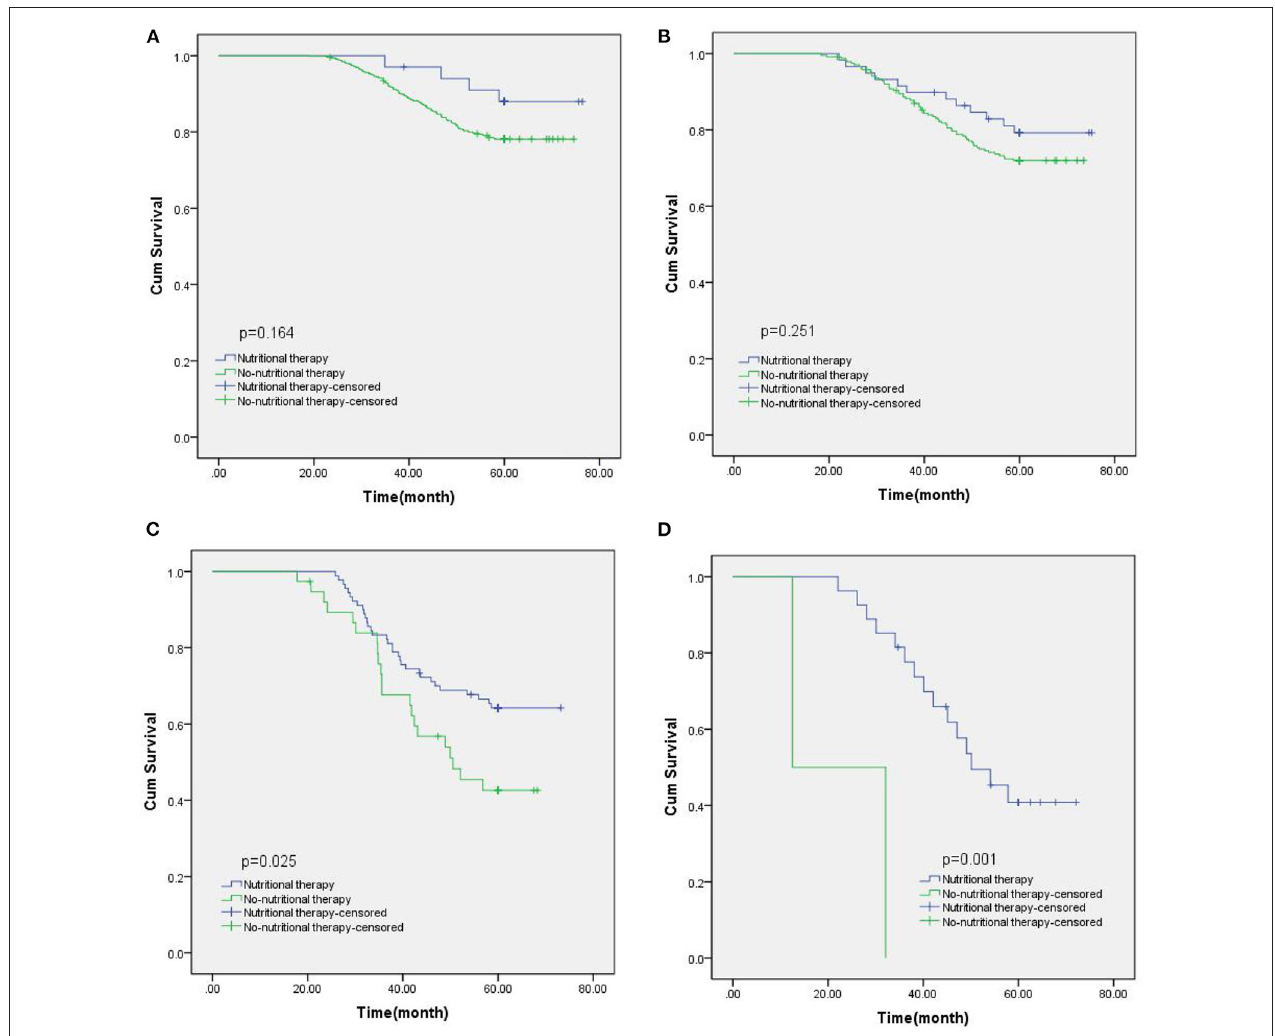
FIGURE 3 | The prognosis of GIST patients with different PG-SGA scores in nutritional therapy and without any intervention. (A) PG-SGA scores: 0 ∼ 1; (B) PG-SGA scores: 2 ∼ 3; ( C) PG-SGA scores: 4 ∼ 8; (D) PG-SGA scores: ≥ 9.